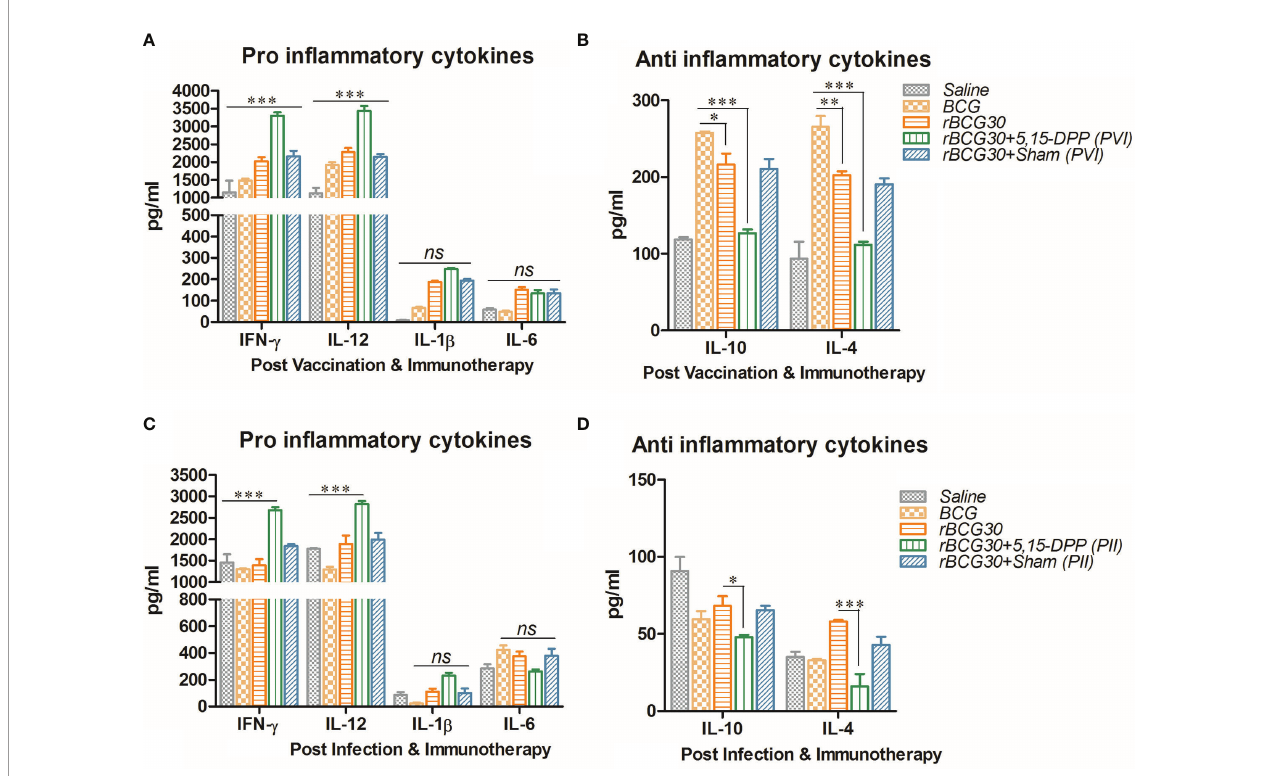
FIGURE 4 | Splenocytes cytokine expression at post vaccination and immunotherapy (PVI) as well as post infection and immunotherapy (PII). The level of signature innate cytokines (IL-1 b and IL-6); Th1 cytokines (IFN- g and IL-12), and anti-in fl ammatory cytokines (IL-10 and IL-4), was estimated following (A, B) PVI and (C, D) PII, using sandwich ELISA in the splenocyte culture supernatants belonging to the various immunized groups. Cells were uniformly stimulated with native Ag85B antigen from Mtb (5 µg/ml). Differential expression levels of cytokines in various immunized groups are presented as bar diagrams. The data were analyzed by employing Two-way ANOVA followed by Bonferroni ’ s multiple comparison test and are shown as the means ( ± SEM) of one of the two experiments with similar observations performed in triplicate from the pooled cells of at least three animals per group, where p values; viz. p<0.05(*), p<0.01(**), and p<0.001(***) were considered signi fi cant. ns, non-signi fi